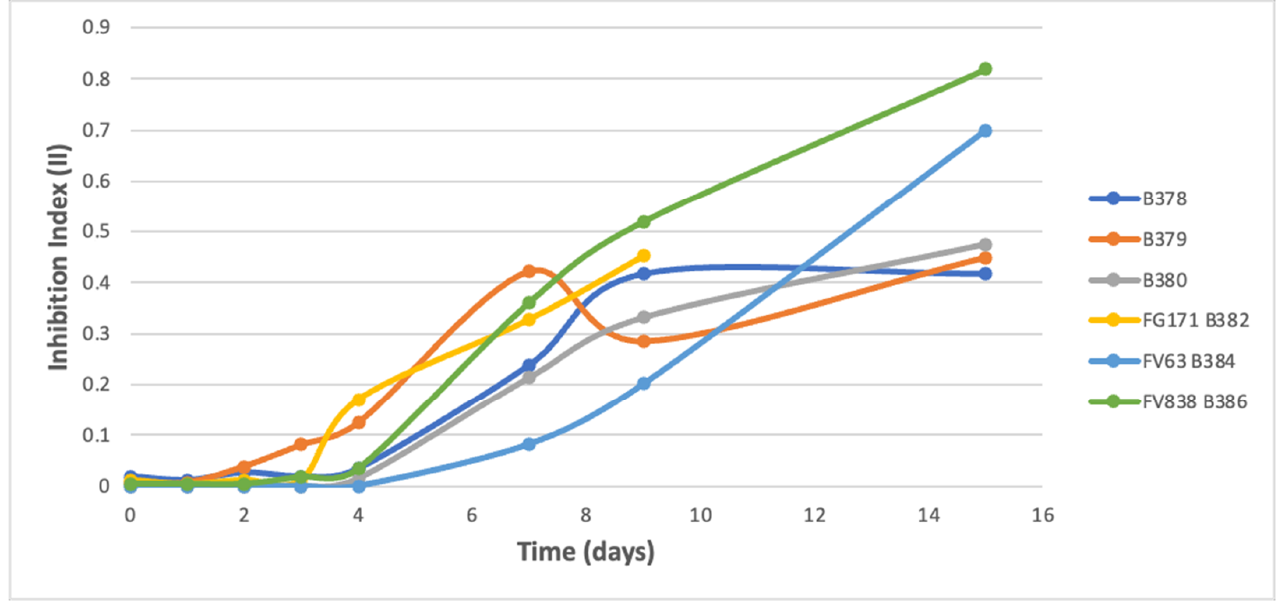
Figure 4. Kinetic curves of global inhibition indexes from the challenge co-cultures of Bacillus velezensis B25 against pathogenic fungi Fusarium moniliforme B378; Microdochium nivale B379; Septoria nodorum B380; Fusarium graminearum FG171 B382; Fusarium verticillioides FV63 B384; and Fusarium verticillioides FV838 B386.